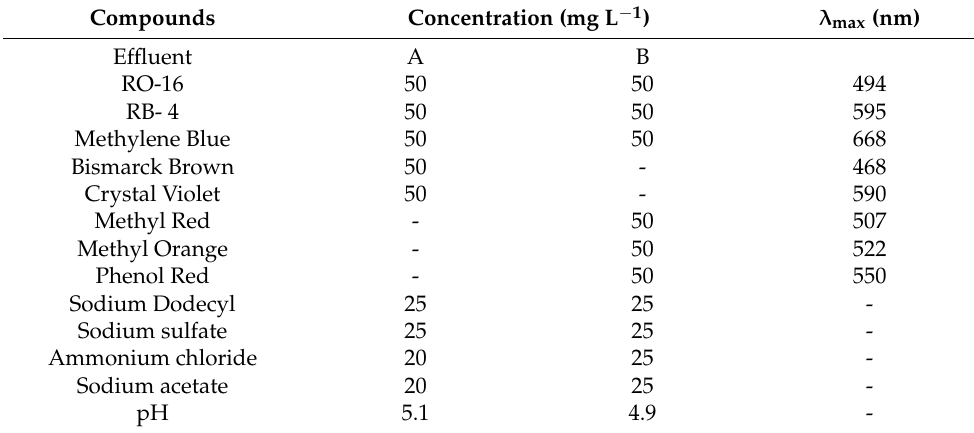
Table 1. Effluent compositions and